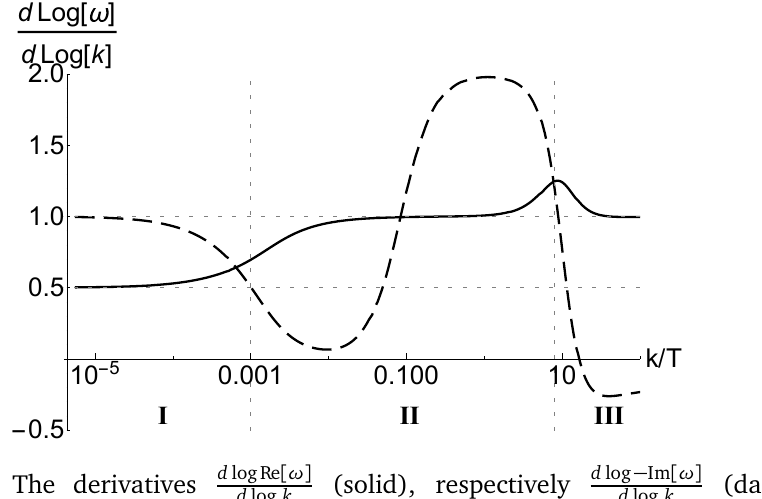
Figure 3: The derivatives d logRe for the lowest collective mode at µ/ T ≈ 0.08 with p = k / 2. Note